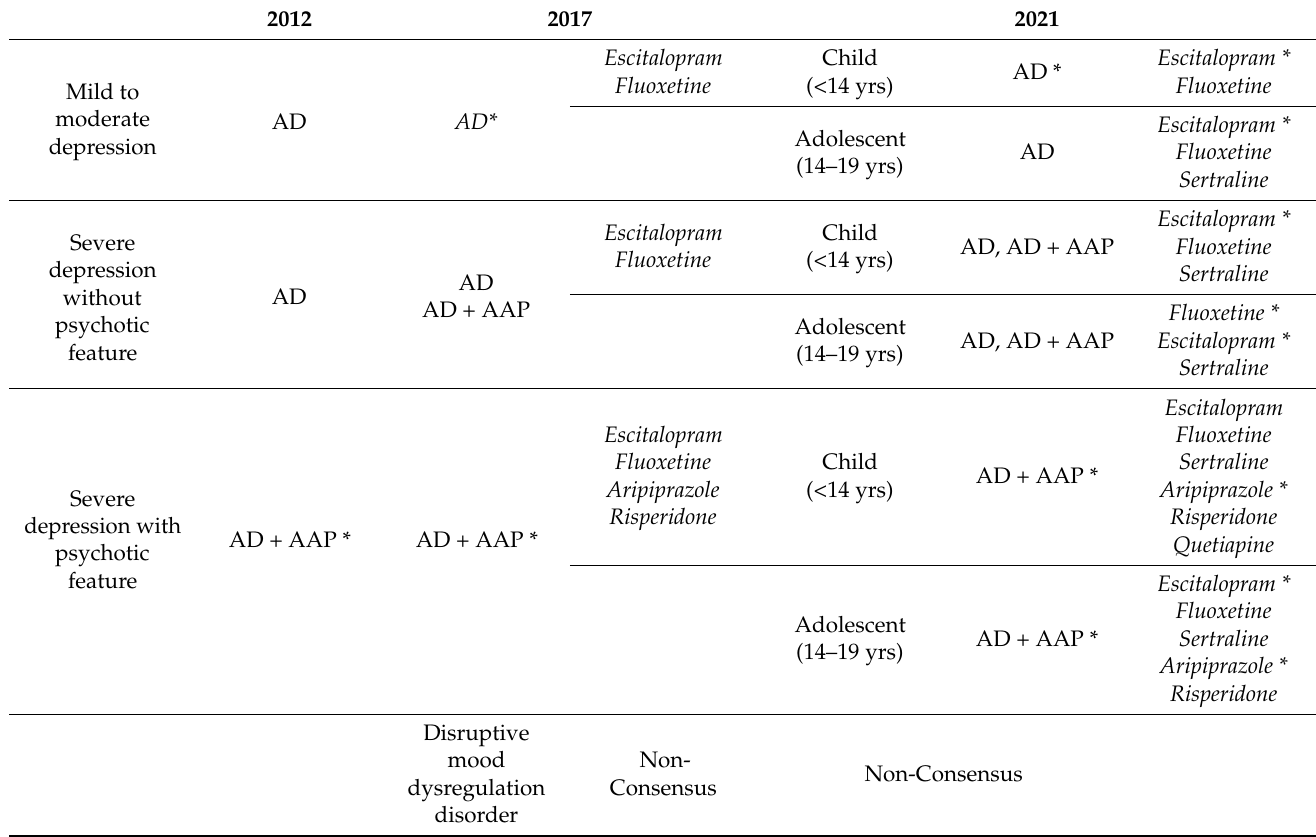
Table 4. First-line-treatment strategies for children and adolescents of